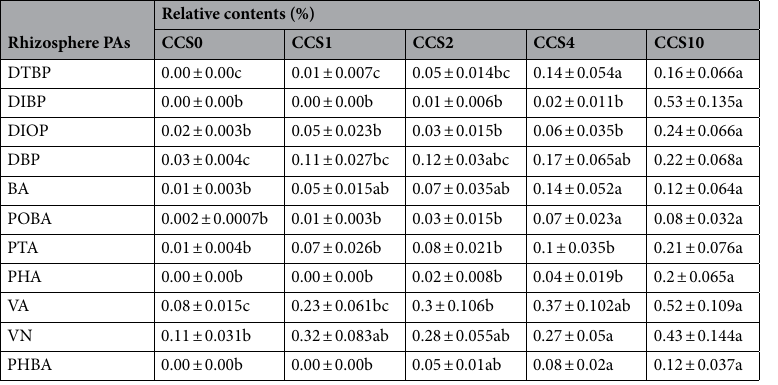
Table 1. The relative contents of rhizosphere phenolic allelochemicals (PAs) in tobacco-planting soils with different continuous cropping years. *DTBP, 2,4-Di-tert-butylphenol; DIBP, diisobutyl phthalate; DIOP, diisooctyl phthalate; DBP, di-n-butyl phthalate; BA, benzoic acid; POBA, p-hydroxybenzaldehyde; PTA, terephthalic acid; PHA, phthalic acid; VA, vanillic acid; VN, vanillin; PHBA, p-hydroxybenzoic acid; CCS0, non-continuous cropping soils; CCS1, CCS2, CCS4 and CCS10, continuous cropping soils where only tobacco was planted for 1, 2, 4, and 10 years respectively. Different letters indicate significant difference ( P < 0.05) according to Duncan’s multiple range